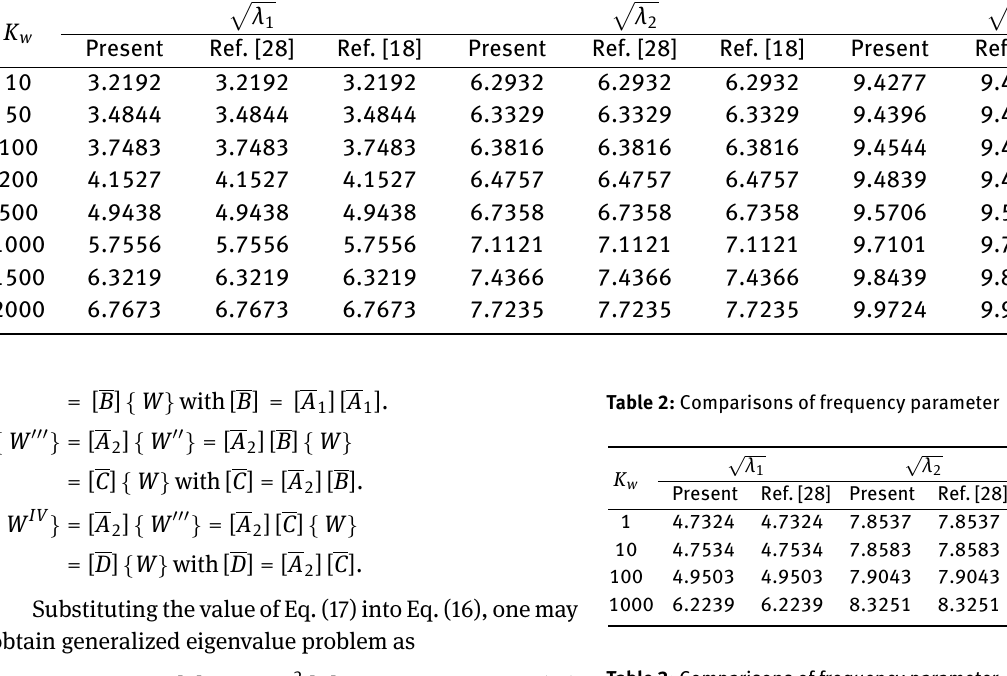
Table 3: Comparisons of frequency parameter K w